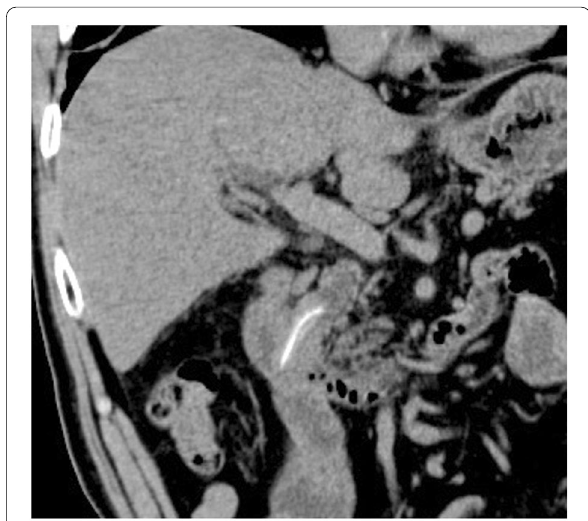
Fig. 2 The coronal plane computed tomography (CT) image showing a common bile duct (CBD) stone along the length of the CBD, with a needle-shaped calcification density at the